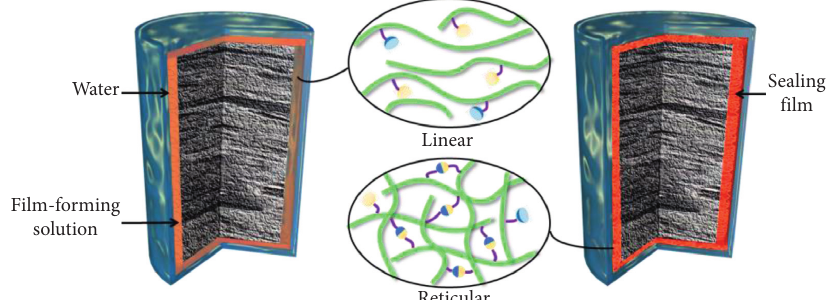
Figure 1: Schematic of in situ crosslinking film-forming mechanism.